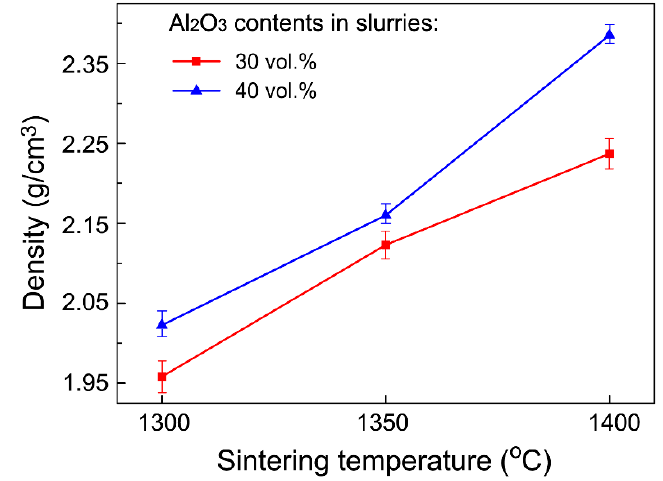
Figure 5. Variation of density of porous Al 2 O 3 ceramics with sintering temperature.